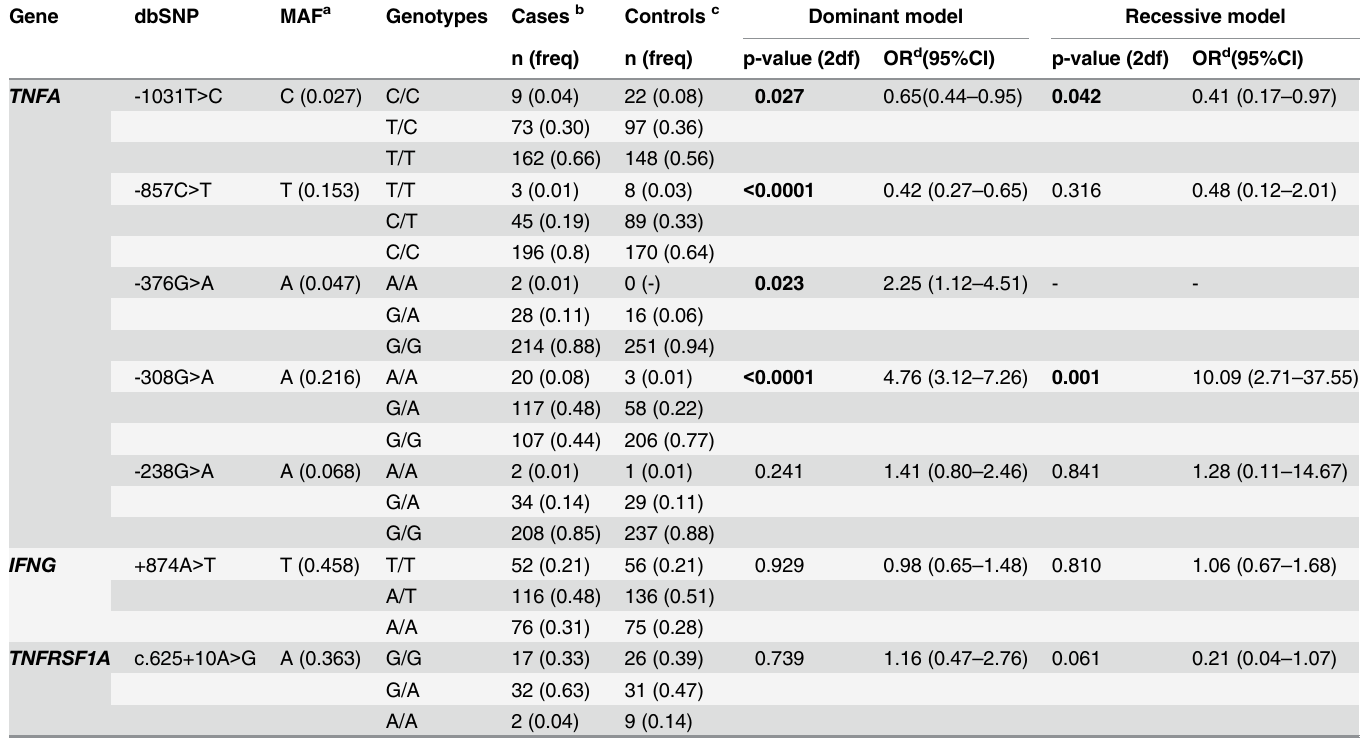
Table 3. TNFA , IFNG and TNFRSF1A gene polymorphisms in